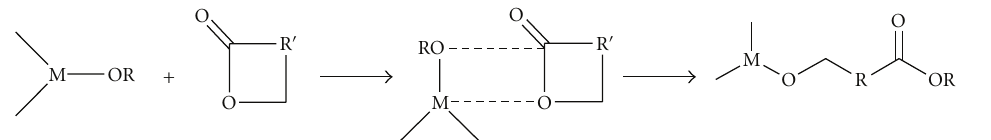
Scheme 4: Coordinate insertion mechanism of polymerization of lactones.